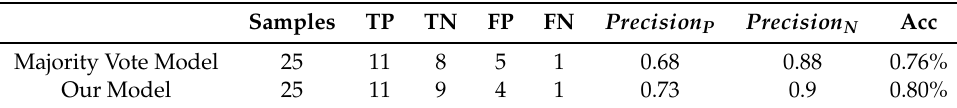
Table 8. Results